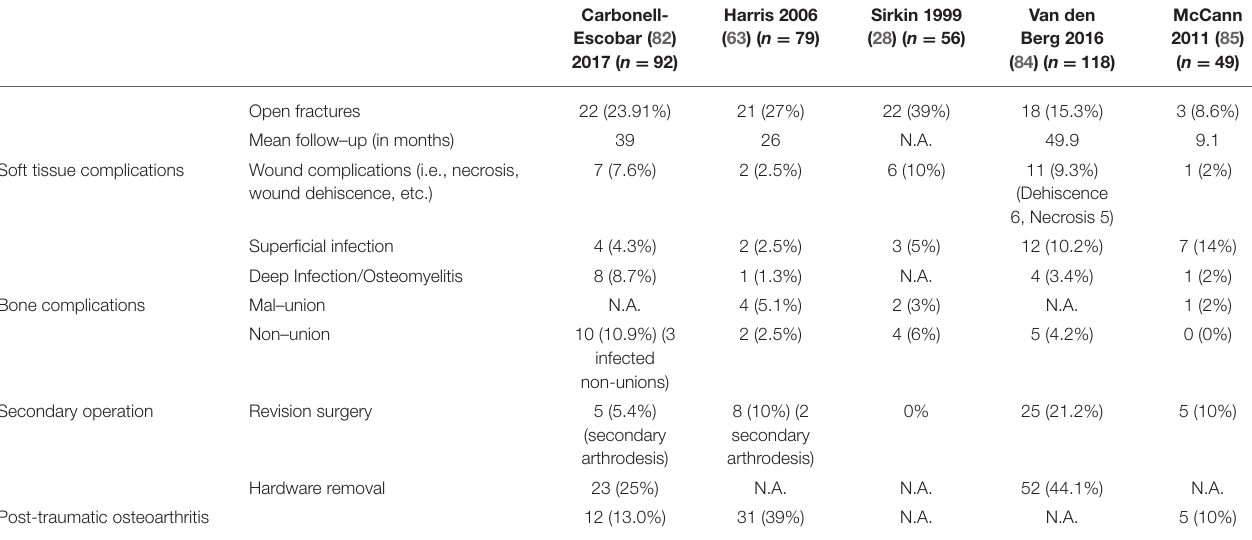
TABLE 1 | Most common complications after operative treatment of tibial pilon